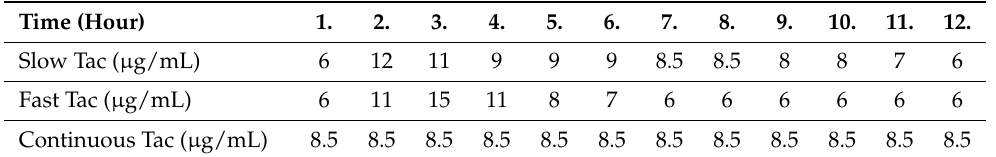
Table 4. Based on the results of our former study, INS-1 cells were treated with the following Tac concentrations hourly for a period of twelve hours to model slow, fast and continuous Tac metabolism